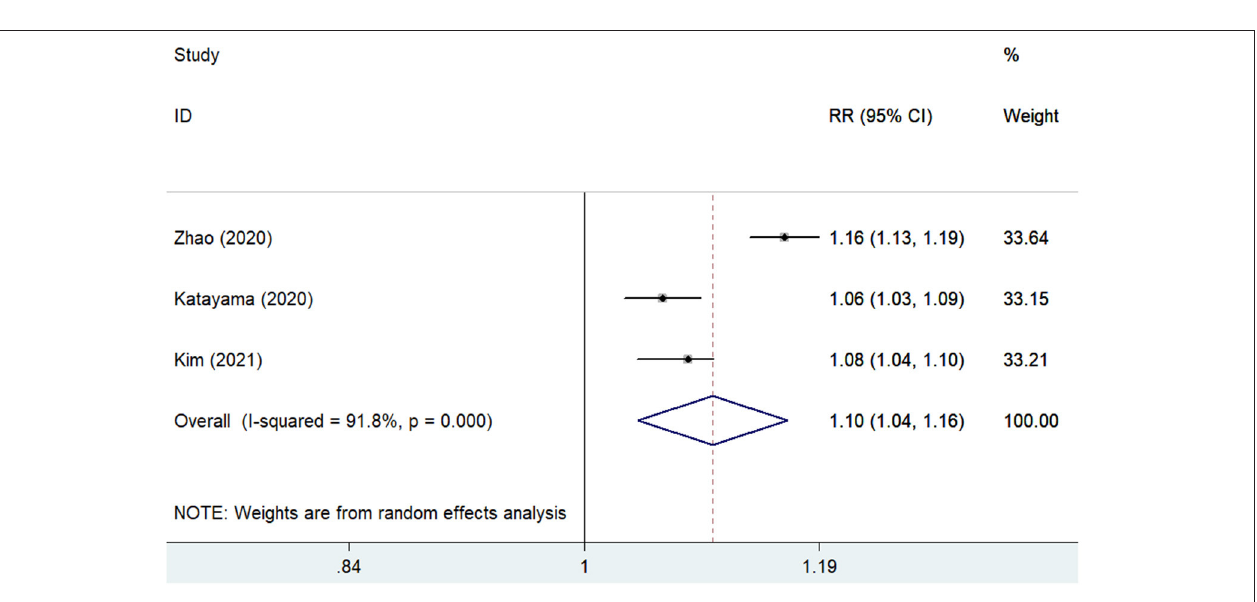
FIGURE 5 | Forest plots showing the pooled RR and 95% CI of major adverse cardiovascular events for per point decrease in GNRI. RR, risk ratio; CI, confidence interval; GNRI, Geriatric Nutritional Risk